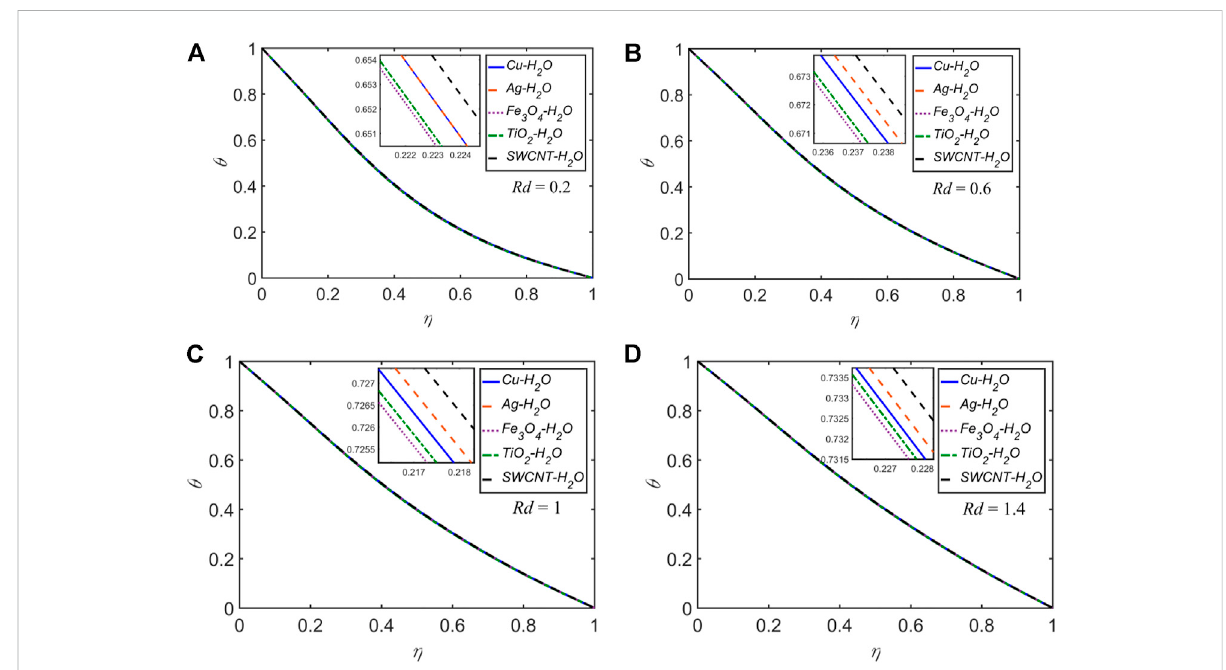
The temperature pro fi le θ versus η at x (cid:2) 0 and t (cid:2) 0 . 25 for the fi ve NFs for distinct values of Rd .